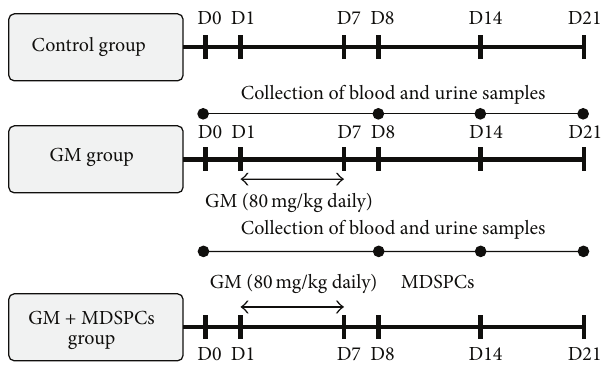
Figure 1: Experimental study design flowchart. AKI was induced by intraperitoneal injection of gentamicin at 80mg/kg daily for 7 consecutive days. Rats were randomly divided into 3 groups ( 𝑛 = 6 for each group per time point): Control group (healthy animals), GM group (gentamicin injections only), and GM + MDSPCs group (gentamicin injections plus MDSPCs injection). A single MDSPCS injection (1 × 10 6 cells/500 𝜇 L serum-free medium) was administered intravenously into the tail vein 24 hours after the last gentamicin injection (D8). Blood, urine, and tissue samples were collected to evaluate renal function and tissue damage. Urine vol- ume,urinary( 𝑈 Cr )andserum( 𝑆 Cr )creatininelevels,andglomerular filtration rate (GFR) were determined at day 0 (24 hours prior to gentamicin injection), day 8, day 14, and day 21 of the